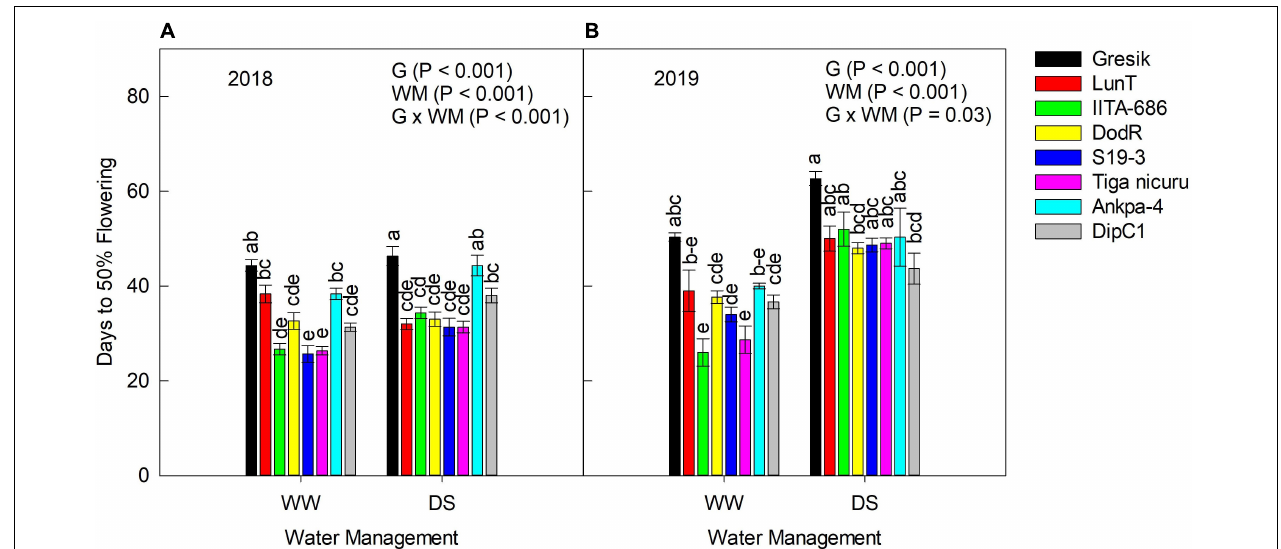
FIGURE 1 | Interaction effect Genotype (G) × Water management (WM) on days to 50% flowering of eight bambara groundnut genotypes grown in a soil-filled polyvinyl chloride (PVC) columns in a rainout shelter (A) well-watered (WW) and drought stress (DS) during 2018, (B) WW and DS during 2019. The data is mean ± SE values ( n = 3), with different letters showing significant differences by Tukey’s honest significant difference post hoc test for treatments.